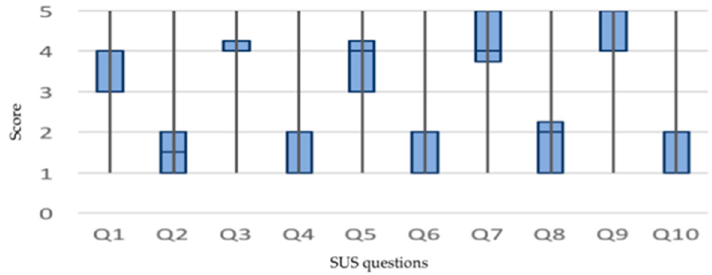
Figure 10. Graphic representation of the scores given by the users to each question of the SUS questionnaire. The questions are detailed in the Table B1.